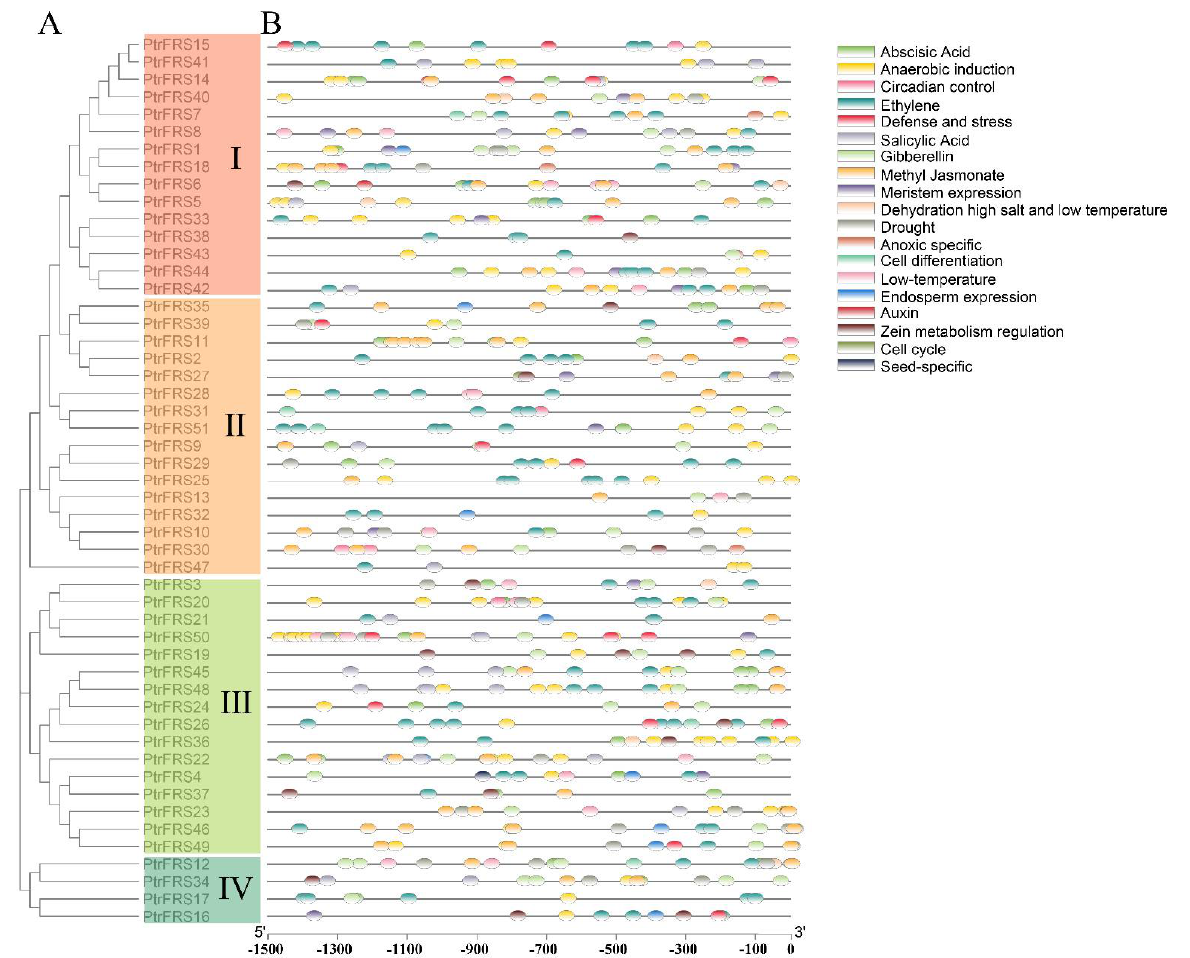
Forests 2021 , 12 , x FOR PEER REVIEW Figure 3. Analysis of the cis-acting elements of PtrFRS s. ( A ) Phylogenetic tree of PtrFRSs. ( B ) Distribution of cis-acting elements in the 1500 bp region upstream of PtrFRS s, with each colored oval representing a different cis-acting element.